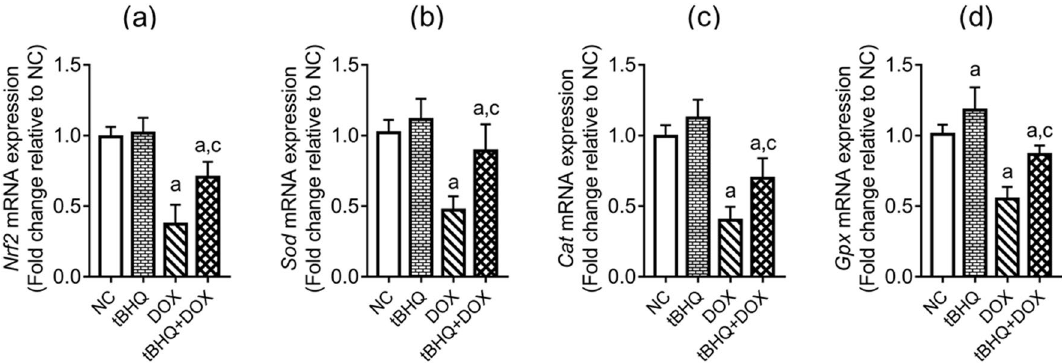
Figure 4. Effect of tBHQ on Nrf2 ( a ), Sod ( b ), Cat ( c ) and Gpx ( d ) mRNA levels in the testis of DOX- treated rats. NC: normal control, tBHQ: tert-butylhydroquinone, DOX: doxorubicin, tBHQ + DOX: tert- butylhydroquinone + doxorubicin, Nrf2: nuclear factor erythroid 2-related factor-2, SOD: superoxide dismutase, CAT: catalase, GPx: glutathione peroxidase. Values are mean ± SD, n = 6. a p < 0.05 versus NC; c p < 0.05 versus DOX (One-way ANOVA with Tukey’s post-hoc test).